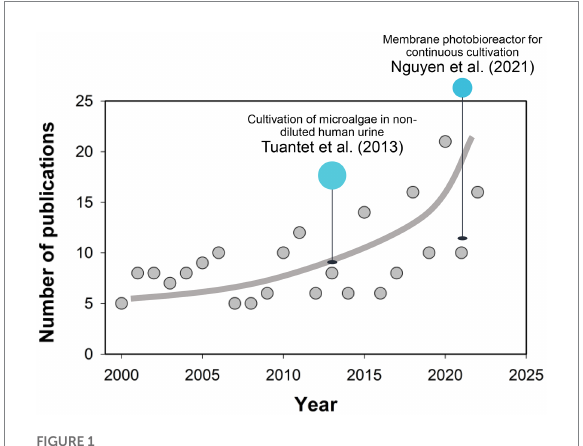
FIGURE 1 Survey of the publications (Elsevier Scopus) in topics related to “(Micro)algae” and “Urine” from 2000 to 2022 (Accessed date: October 29, 2022). Line serves to guide the